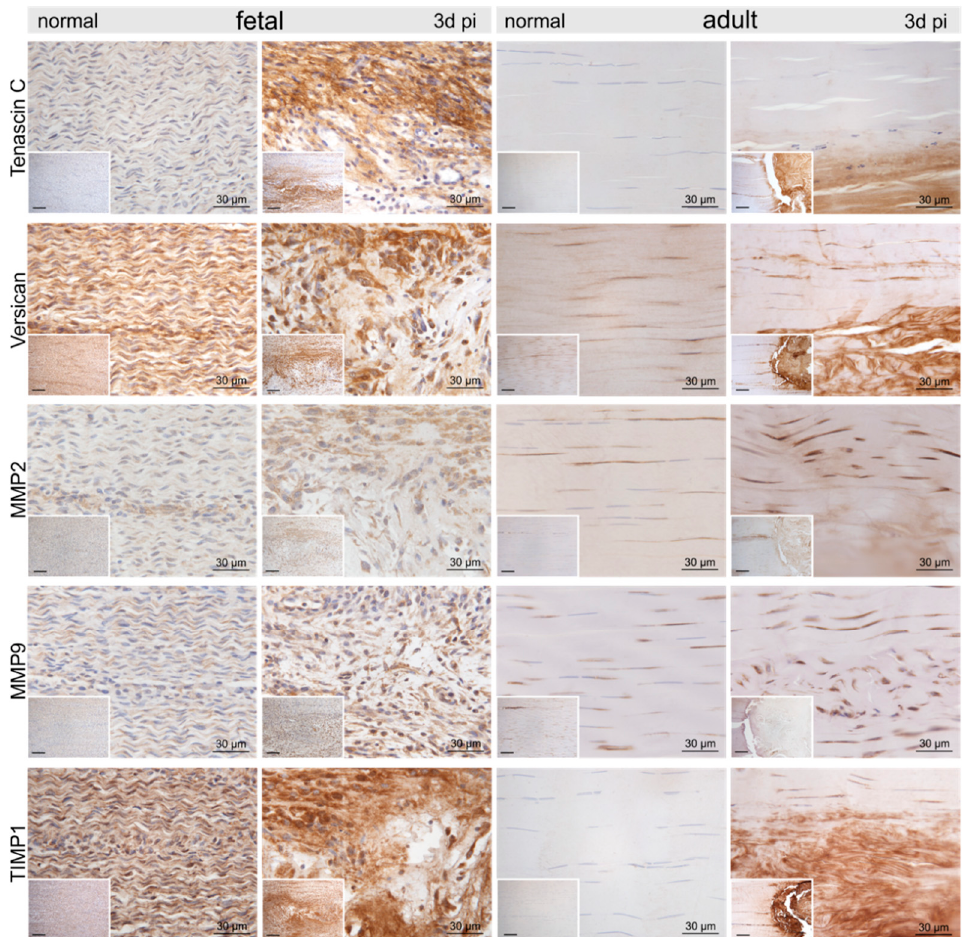
Figure 5. Representative micrographs of normal control and injured fetal and adult tendons three days post-injury (pi). Compared to the control tendons, we found an up-regulation of tenascin-C, versican, matrix metalloproteinase-2 (MMP2), MMP9, and tissue inhibitor of metalloproteinases- 1 (TIMP1) within and around the lesion site in both age groups. Inserts show an overview at 10 × magnification, scale bar = 100 µ